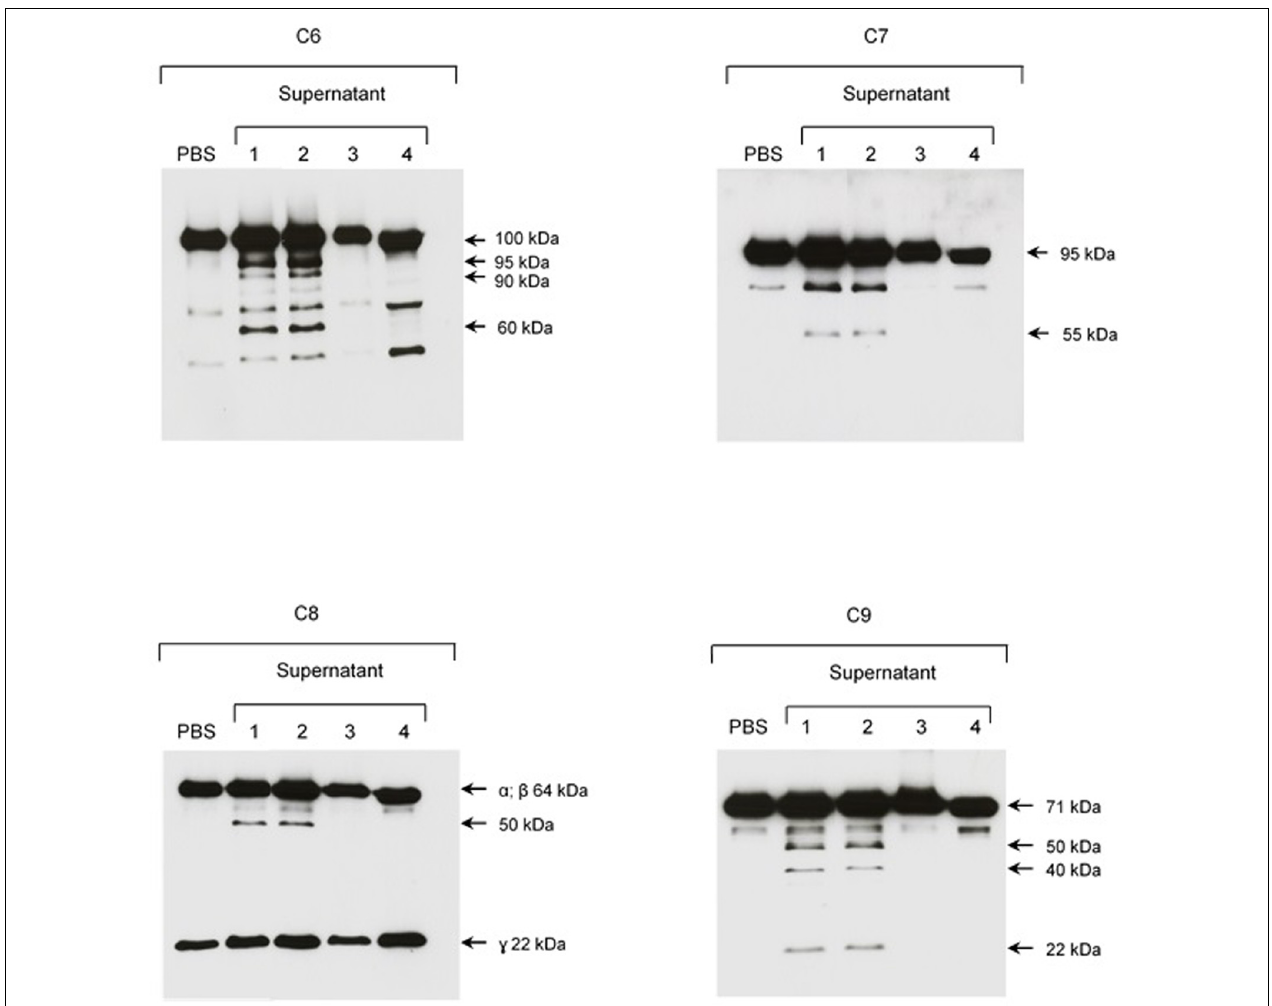
FIGURE 8 | The plasma protease inhibitor α 2M inhibits cleavage of purified C6–C9 proteins by SPL proteases. SPF from L. interrogans serovar Kennewicki strain Fromm was incubated with (1) PBS; (2) Ethanol; (3) 1,10-phenanthroline; and, (4) α 2M for 30 min at room temperature. Next, C6–C9 purified proteins were added to reaction, incubating for 2 h at 37 ◦ C. The cleavage fragments were analyzed by Western blot using specific polyclonal